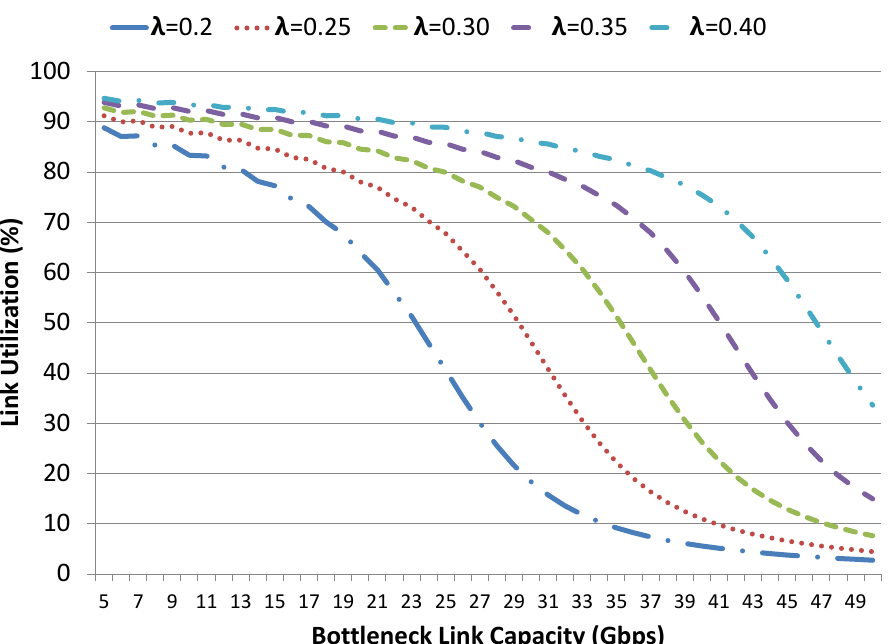
Figure 15. Percentage link capacity utilization by proposed model with varying arrival rates λ = { 0.20,0.25,0.30,0.35,0.40 } and mean volume size V = 120 Gbps. Algorithm 1 can be used for network capacity planning in order to compute